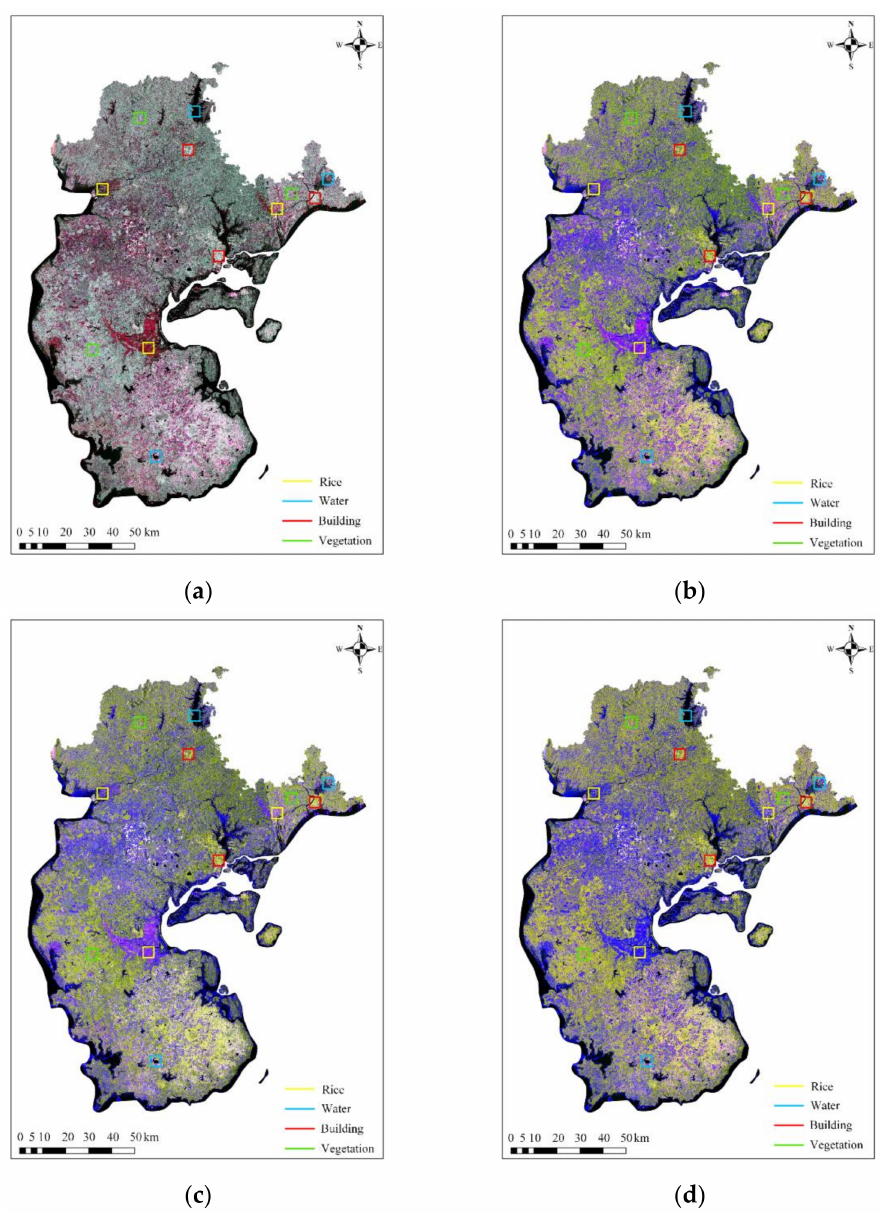
Figure 6. False color chart of time series statistical parameters. ( a ) R: maximum G: